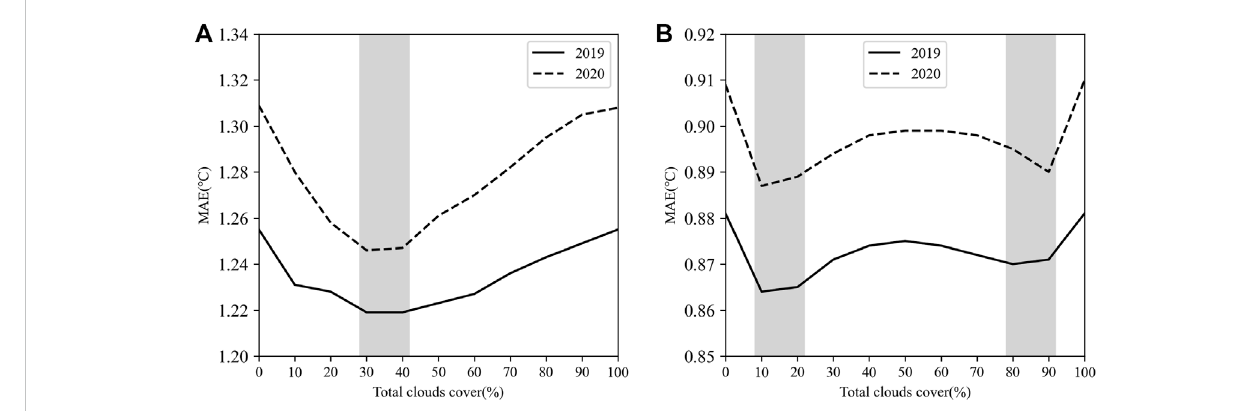
Comparison of theforecast results ofthethree schemes from 2019 to 2020. (A) FA of T max (unit: %), (B) FA ofT min (unit: %), (C) MAE ofT max (unit: ° C), and (D) MAE of T min (unit: °